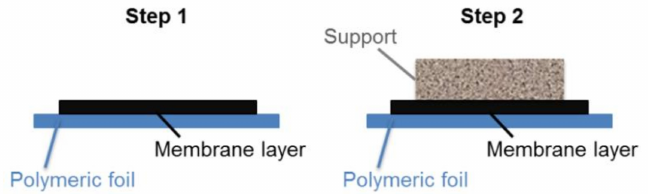
Figure 1. Schematic representation of the two-step sequential tape casting of asymmetric green